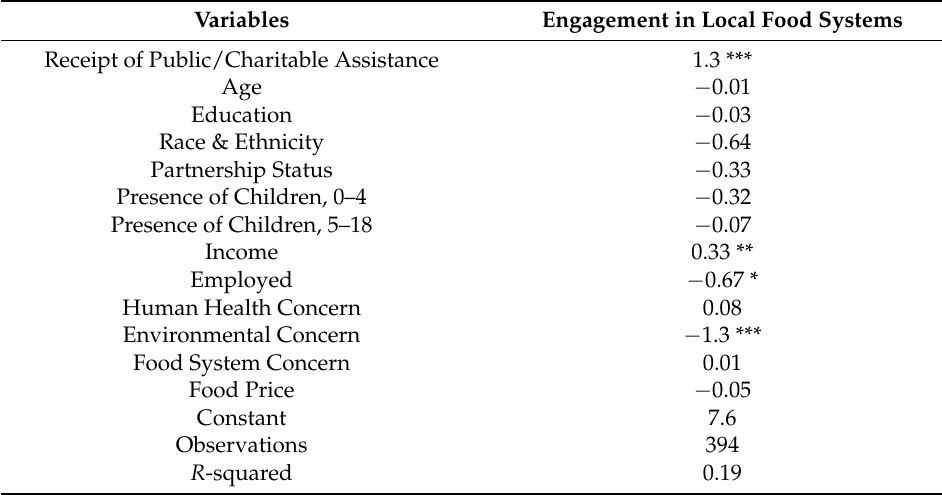
Table 3. Regression model results on engagement in local food